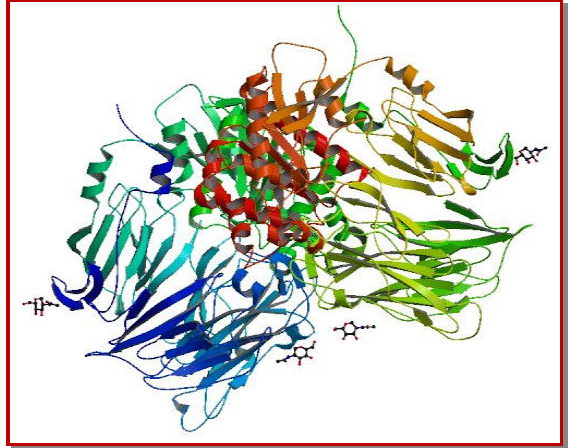
Figure 2: 3D structure of human apo dipeptidyl peptidase-4 pr-